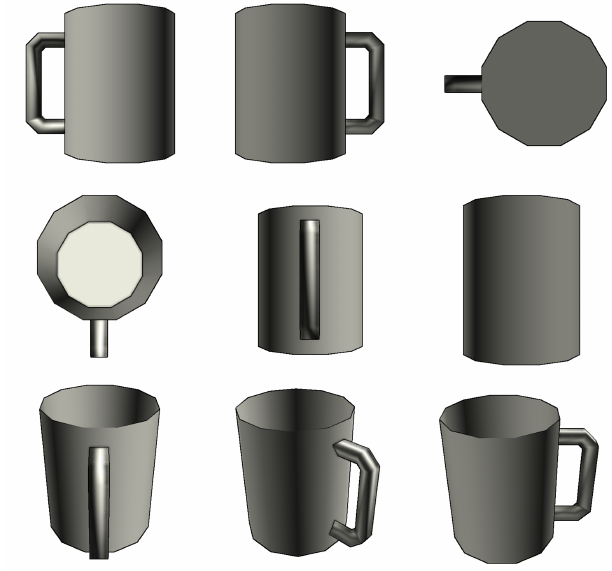
Figure 8. A coffee cup model from the ShapeNetCore